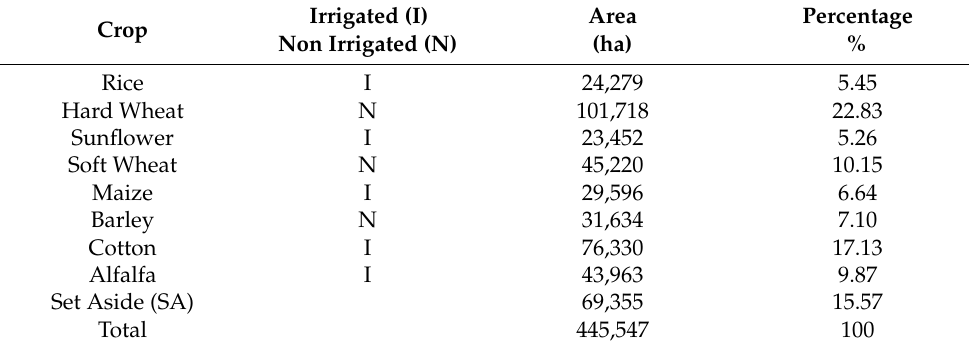
Figure 1. Map of the region of Central Macedonia in Greece. Table 2. Crop plan of the region of Central Macedonia for 2018 [49].